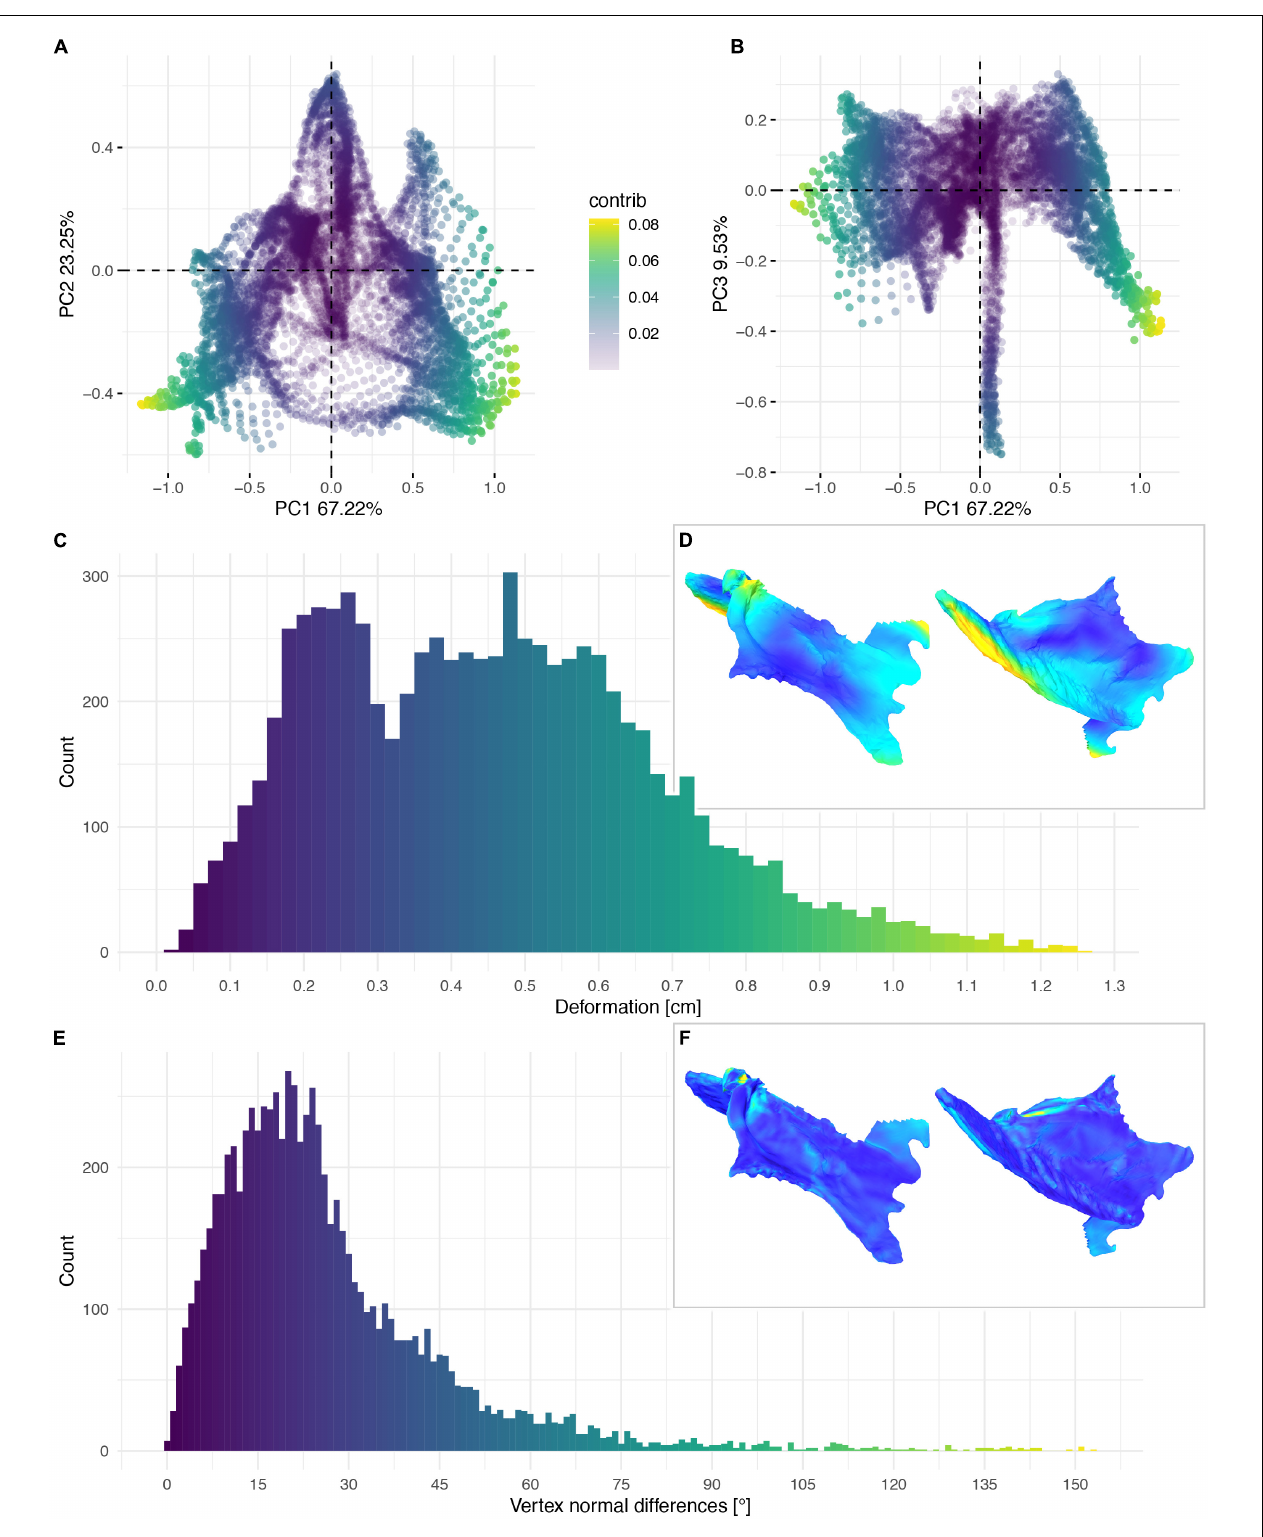
FIGURE 13 | Deformation of KUVP 119673. PCA of the global differences in the components of the vector between corresponding vertices (A,B) . PC1 represents the major axis of deformation. Histograms of the absolute deformation (morphological distance) between the reconstruction and the original specimen (C) and the angles between the different orientations of the corresponding vertex normals (E) . Visualisation of the deformations in oblique views (D,F) .